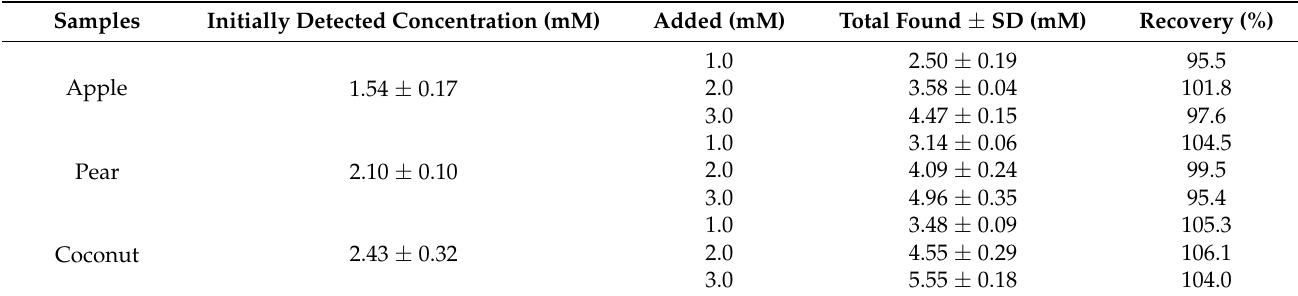
Table 3. Recovery of glucose in fruit samples using the paper